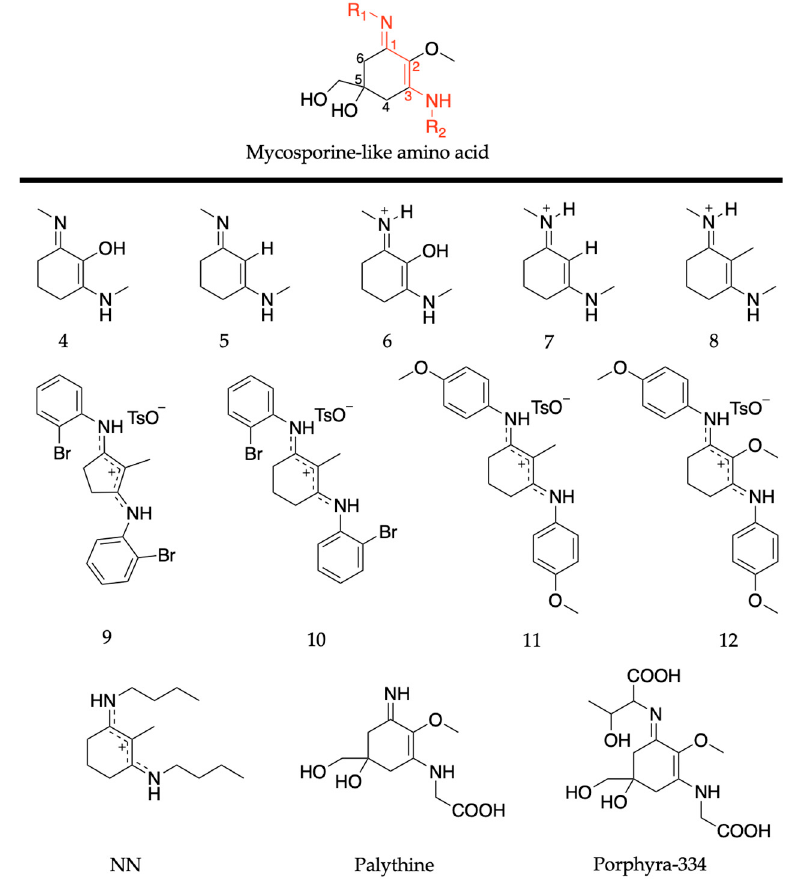
Figure 14. Structures of mycosporine-like amino acid (MAA) motifs studied by Losantos et al. [84,89] and Woolley et al. [85], and the natural MAAs studied by Sampedro [86], Koizumi et al. [88] and Hatakeyama et al. [90] .